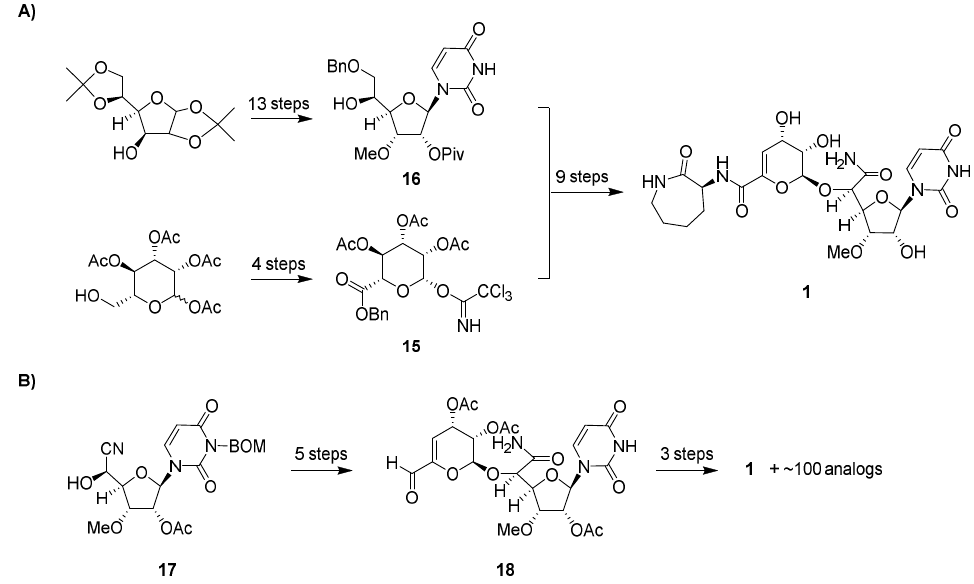
Figure 6. Total synthesis of 1 . ( A ) Strategy for the first reported total synthesis. ( B ) Strategy for